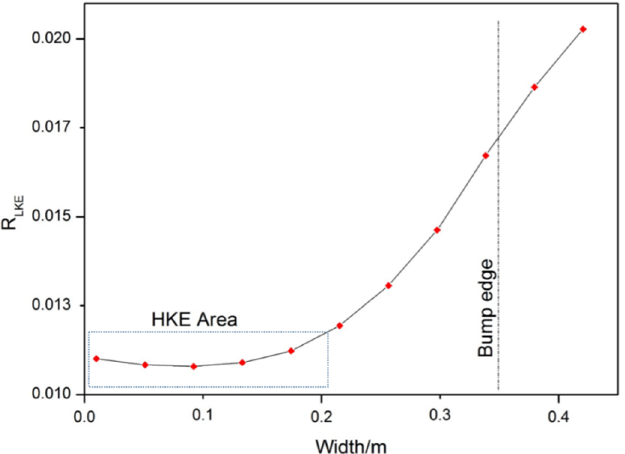
Figure 6. Ratio of LKE flow ( R LKE ) distribution at the inlet presetting region.